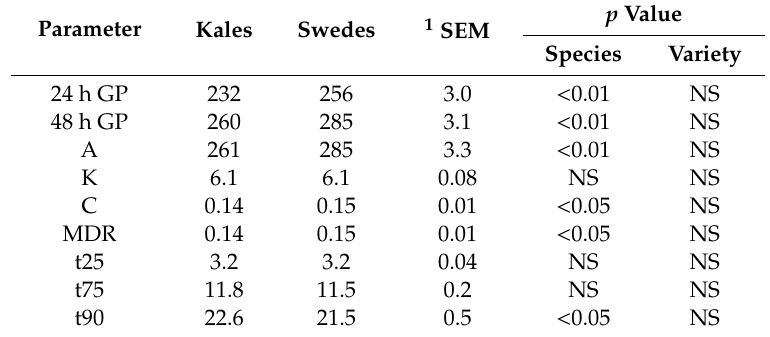
p Value Species Variety